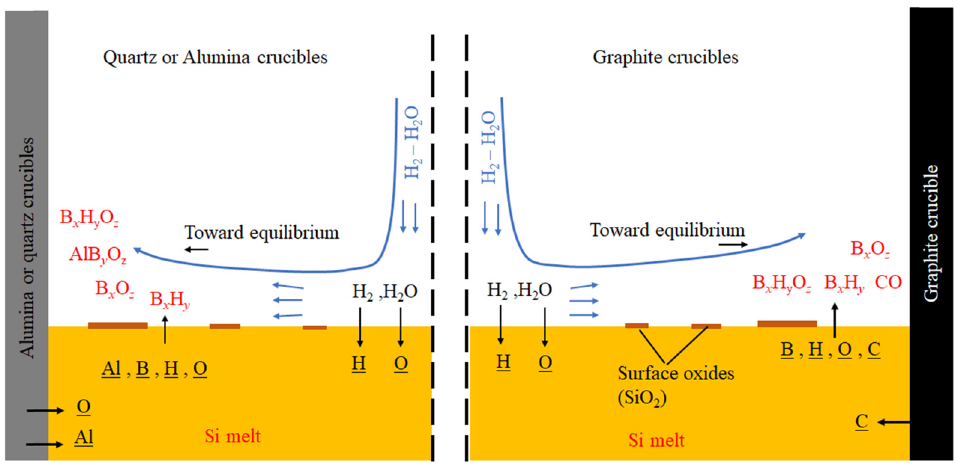
Figure 6: An illustration of the gas re fi ning process in the quartz/alumina ( left ) and graphite crucibles ( right ) , summarizing the B removal mechanisms.